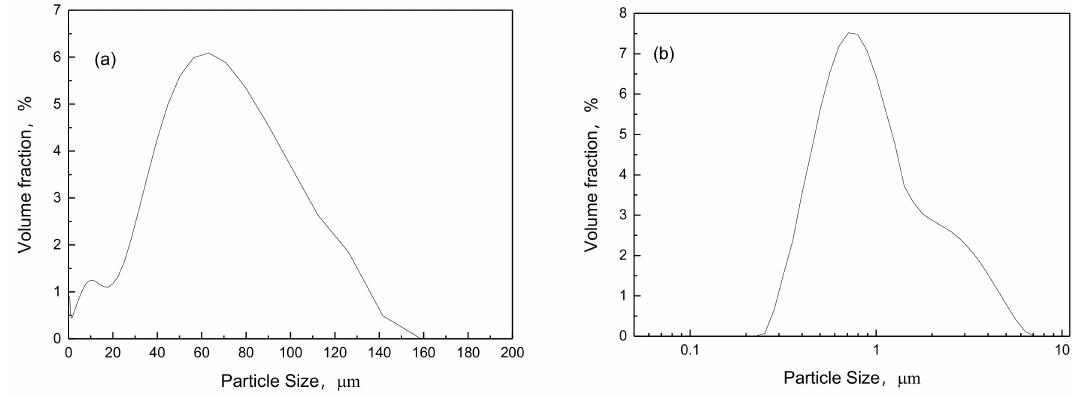
Figure 10. Particle size distribution for ammonium poly-vanadate and vanadium pentoxide ( a ) ammonium poly-vanadate; ( b ) vanadium